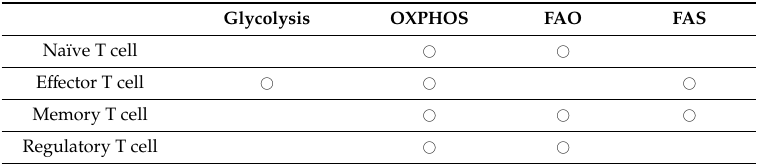
Table 1. The role of di ff erent metabolic pathways in di ff erent kinds of T cells. Increased glycolysis and fatty acid synthesis is required for proliferation and di ff erentiation of e ff ector T cells upon activation. On the other hand, fatty acid oxidation is important for the development of CD8 + T cell memory and for the di ff erentiation of CD4 + regulatory T cells as well. OXPHOS, oxidative phosphorylation; FAO, fatty acid oxidation; FAS, fatty acid